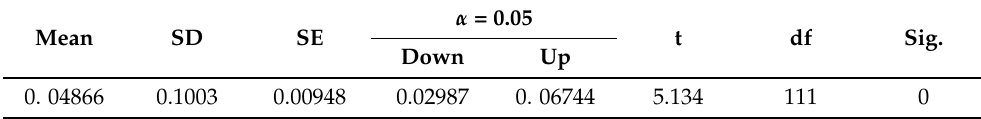
Table 4. Power analysis between our method and Faster-RCNN method.